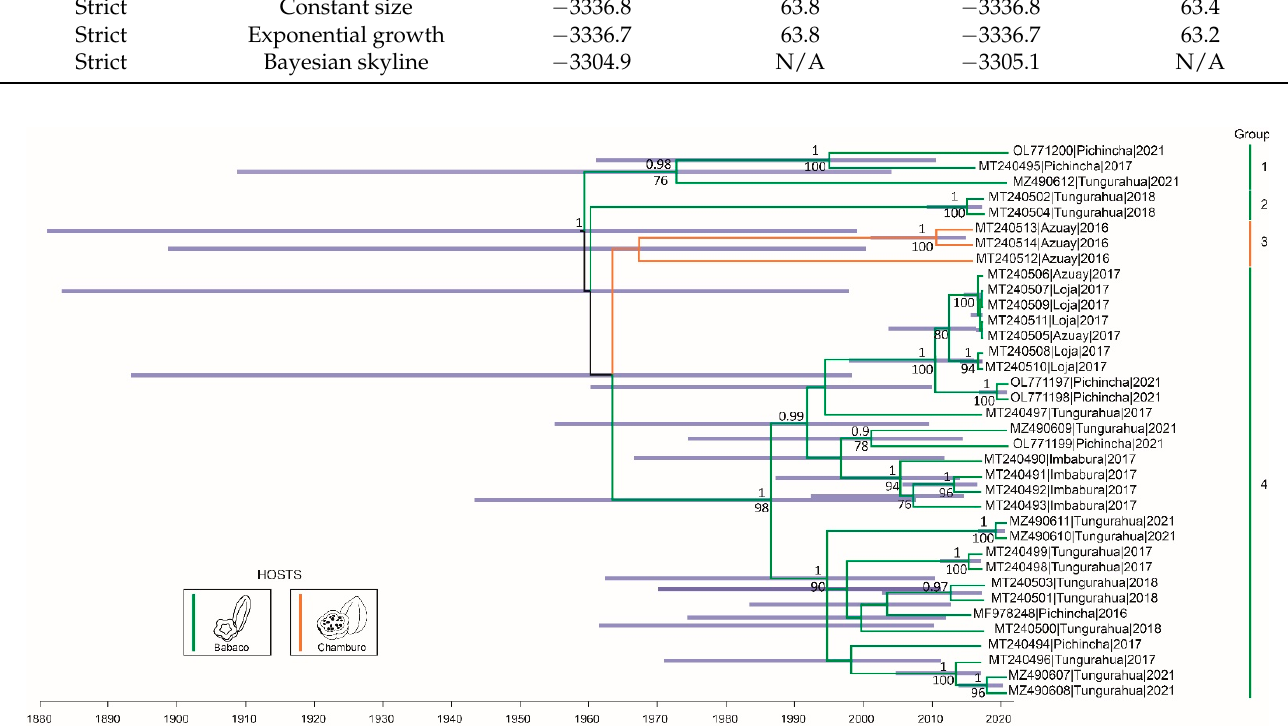
Figure 1. Bayesian phylogenetic tree under strict molecular clock and Bayesian skyline model inferred from 36 nucleotide sequences of the coat protein of babaco mosaic virus. Branches are color-coded according to the host species. Posterior probabilities are shown above the nodes, and bootstrap support values from maximum-likelihood inference are shown below the nodes. Only posterior probability values higher than 0.9 and bootstrap values above 50 are shown. Purple bars represent the 95% HPD age intervals at each node. Province and year are next to their accession